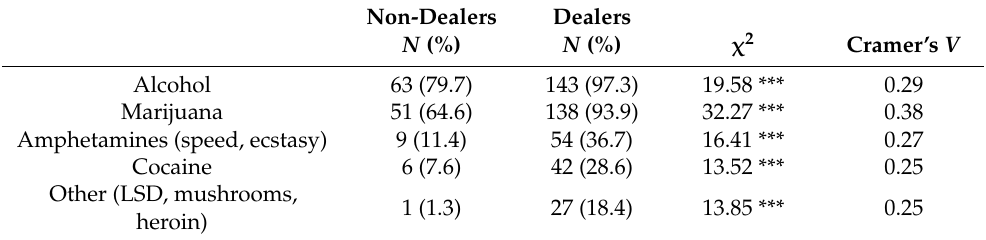
Table 3. Substance Use Among Dealers ( N = 79) and Non-Dealers ( N =